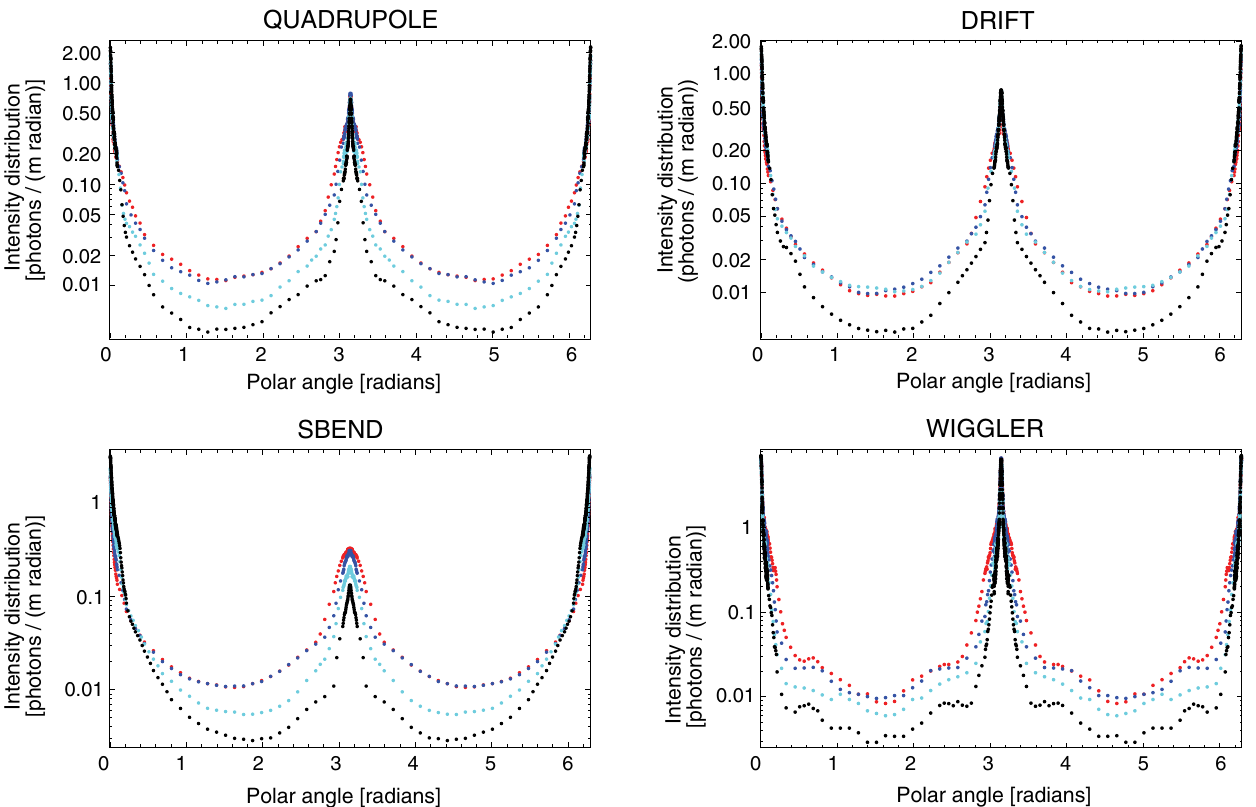
FIG. 14. Absorbed photon distribution vs. polar angle averaged over each type of magnetic environment. Zero angle corresponds to the radial outside direction. The different colors correspond different scattering conditions: (a) Black: pure specular scattering; (b) Cyan: scattering from a polished surface with σ ¼ 4 nm, T ¼ 200 nm; (c) Blue: scattering from a rough surface with σ ¼ 100 nm, T ¼ 5500 nm; (d) Red: scattering from a rough surface with σ ¼ 200 nm, T ¼ 5500 nm.